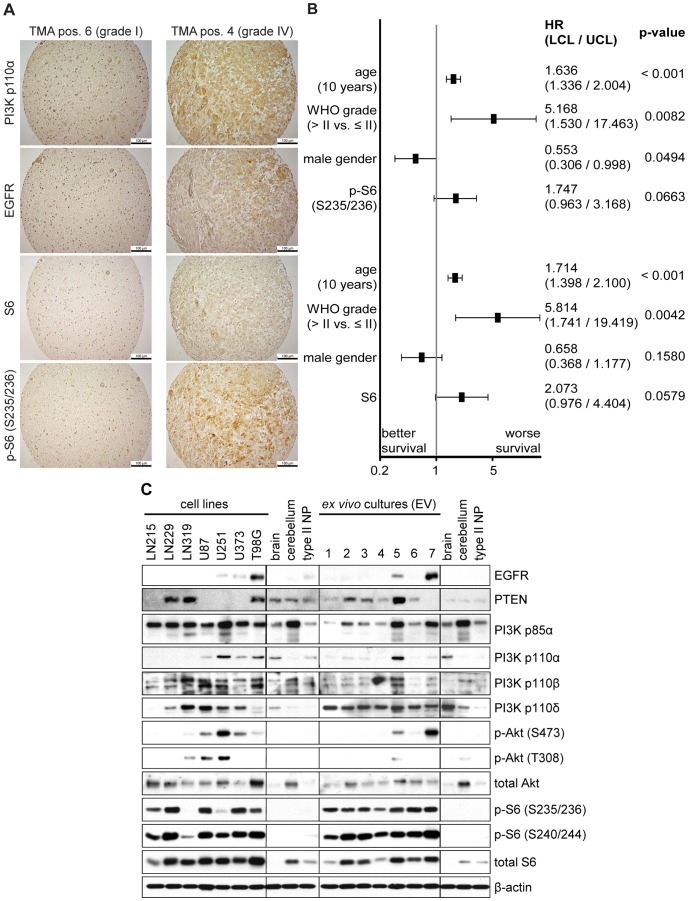
Expression analysis of proteins in the PI3K/Akt/mTOR signaling pathway in glioma and GBM samples.(A) IHC staining of glioma tissue microarray demonstrating increased expression of all antigens shown in GBM (WHO grade IV) compared to pilocytic astrocytoma (WHO grade I). Bars represent 100 μm. (B) Multivariable Cox-regression of IHC factors in 74 glioma patients by individually adding the immunostaining status to the clinical factors age, gender, and WHO grade. Results for p-S6 (S235/236) and S6 are shown in the upper and lower panel, respectively. HR: hazard ratio, LCL/UCL: lower/upper boundary of 95% confidence interval for HR. (C) Western blot analysis of protein levels of EGFR, PTEN, class IA PI3K isoforms, and downstream signaling proteins Akt and S6 in human GBM cell lines and ex vivo cultures. Normal human brain and cerebellum tissue as well as non-transformed type II human pneumocytes were used as controls.